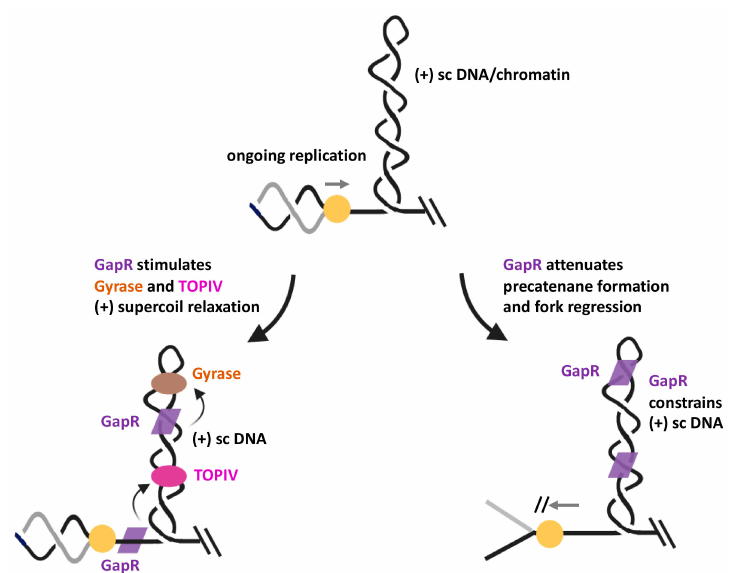
Figure 3. Proposed model for GapR functioning as a supercoil sink. GapR tracks along DNA and binds with a high a ffi nity to overtwisted DNA, where it stimulates ( + ) supercoil relaxation by both bacterial type 2 topoisomerases (bottom left). The protein is also constraining ( + ) supercoils ahead of the replication fork, perhaps via some form of helix clamping [89], thereby potentially minimizing replication stress due to excessive formation of precatenanes or fork reversal (bottom